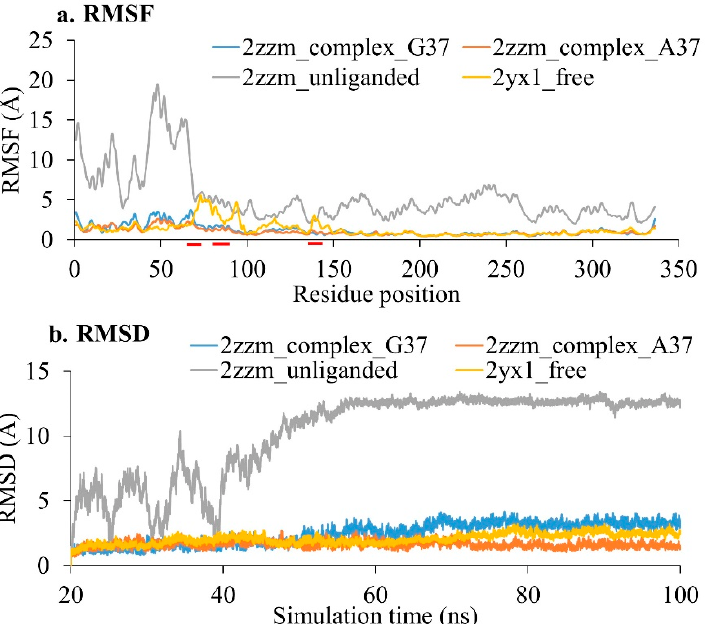
Figure 2. ( a ) Root mean square fluctuation (RMSF) and ( b ) root mean square deviation (RMSD) of a wild-type tRNA methyltransferase complex (2zzm_complex_G37), a complex with G37A tRNA mutation (2zzm_complex_A37), unliganded protein of the complex (2zzm_unliganded), and free protein (2yx1_free). The DOT regions are marked with red colour in the X-axis.